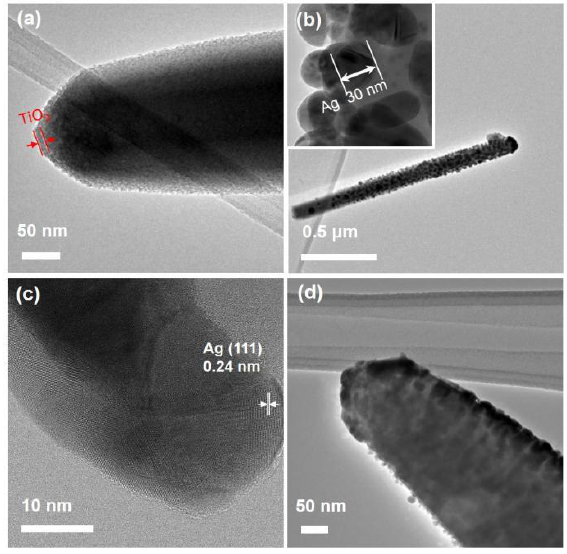
Figure 3. TEM and HRTEM images of ( a ) tip of a ZT nanorod, ( b ) single ZA nanorod with the inset image focus on the Ag NPs on its surface, ( c ) HRTEM image of an Ag NP on the surface of ZA nanorod, and ( d ) tip of a ZAT nanorod.